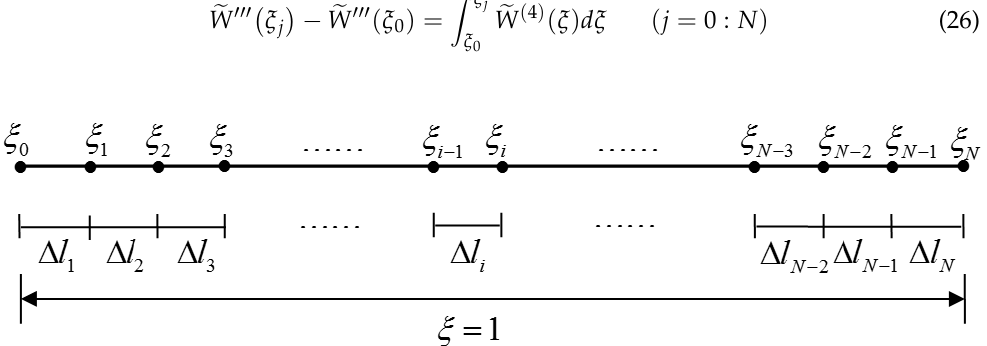
Figure 2. Interpolation Matrix Method Calculation Model for Axially Moving FGM Beams. The unknown derivative (cid:101) W ( 4 ) ( ξ ) in the above equation is approximated by the